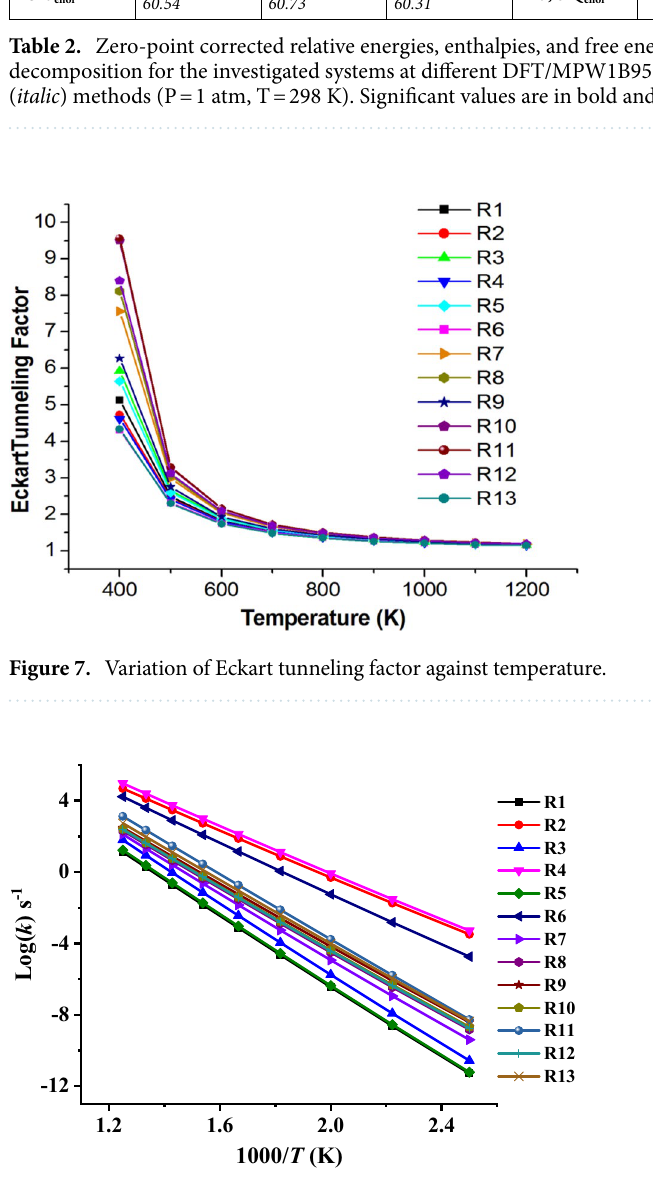
Figure 8. TST/Eck rate constants for unimolecular decomposition reactions of the investigated ethoxyquinolines and ethoxyisoquinolines (R1–R13) at ( T = 400–1200 K, p = 1 atm) calculated at CBS-QB3// BMK/6–31+G(d,p)